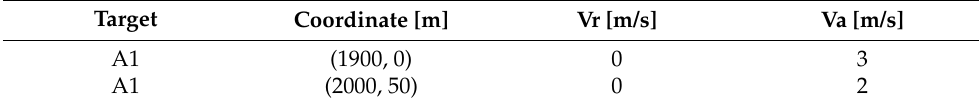
Figure 12. The NCUT Risk Radar GBSAR System. Table 3. Target parameters of synthetic data.